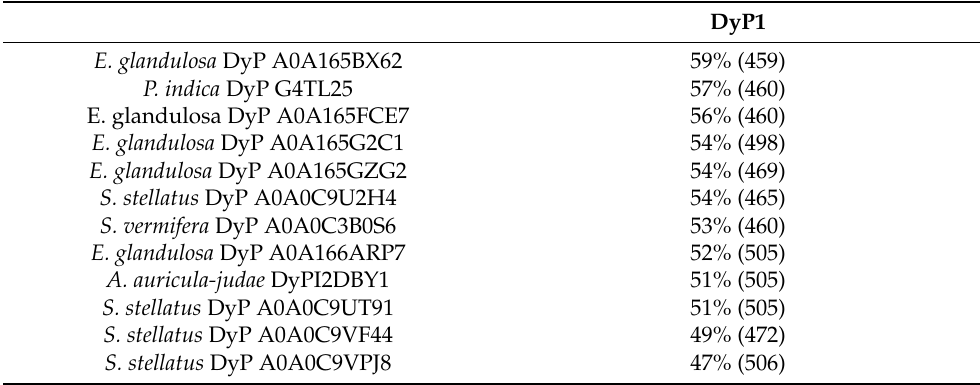
Table 2. DyPs deposited from the UniProtKB/Swiss-Prot database presenting the highest amino acid sequence identities (47–59%) with DyP1 from mangrove soils (the number of residue pairs considered for each comparison is shown in brackets). The DyP entry names of 12 enzymes are indicated together with the fungal species they belong to, from the orders Auriculariales ( Exidia glandulosa and A. auricula - judae ), Sebacinales ( Piriformospora indica and Serendipita vermifera ), and Geastrales ( Sphaerobolus stellatus